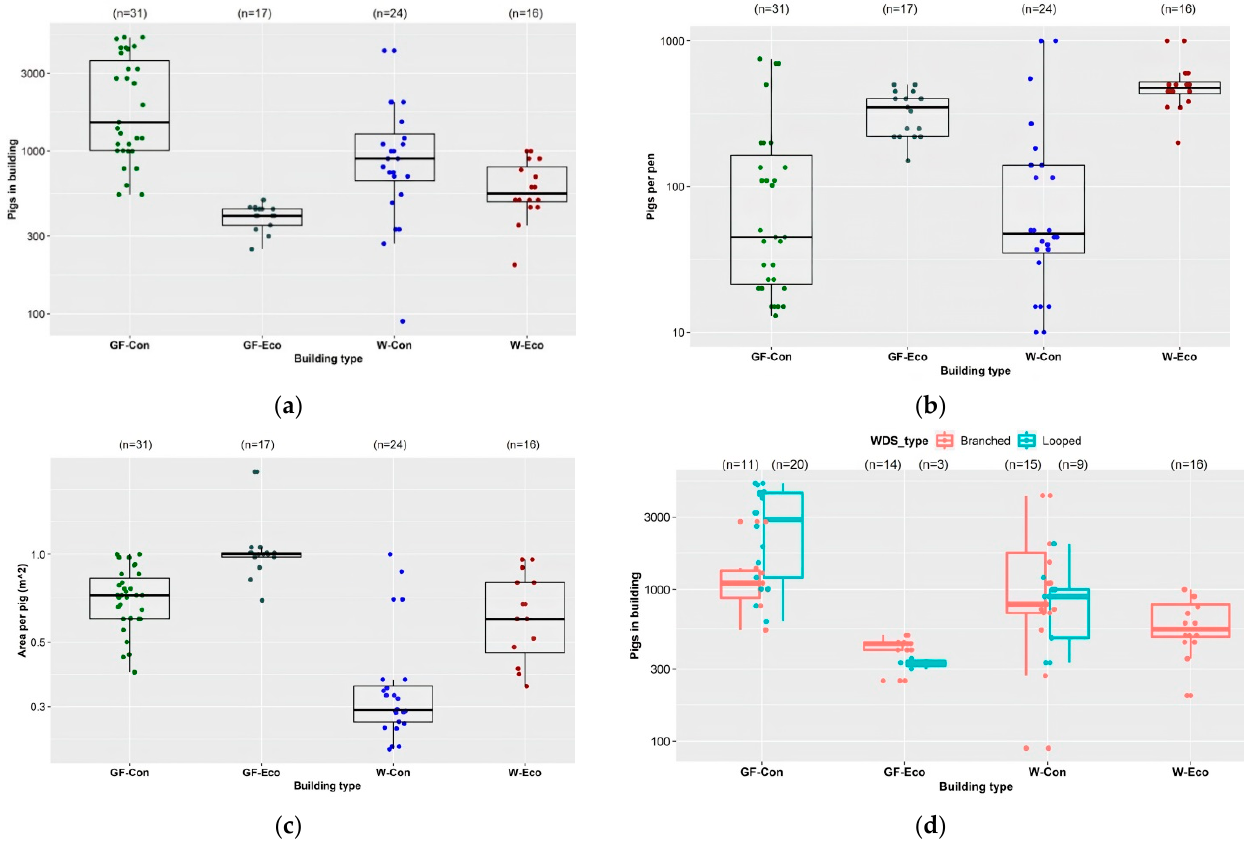
Figure 2. By building type: ( a ) number of pigs in each building, (GF-Con: Q1: 1008, Median: 1500, Mean: 2302, Q3: 3602;